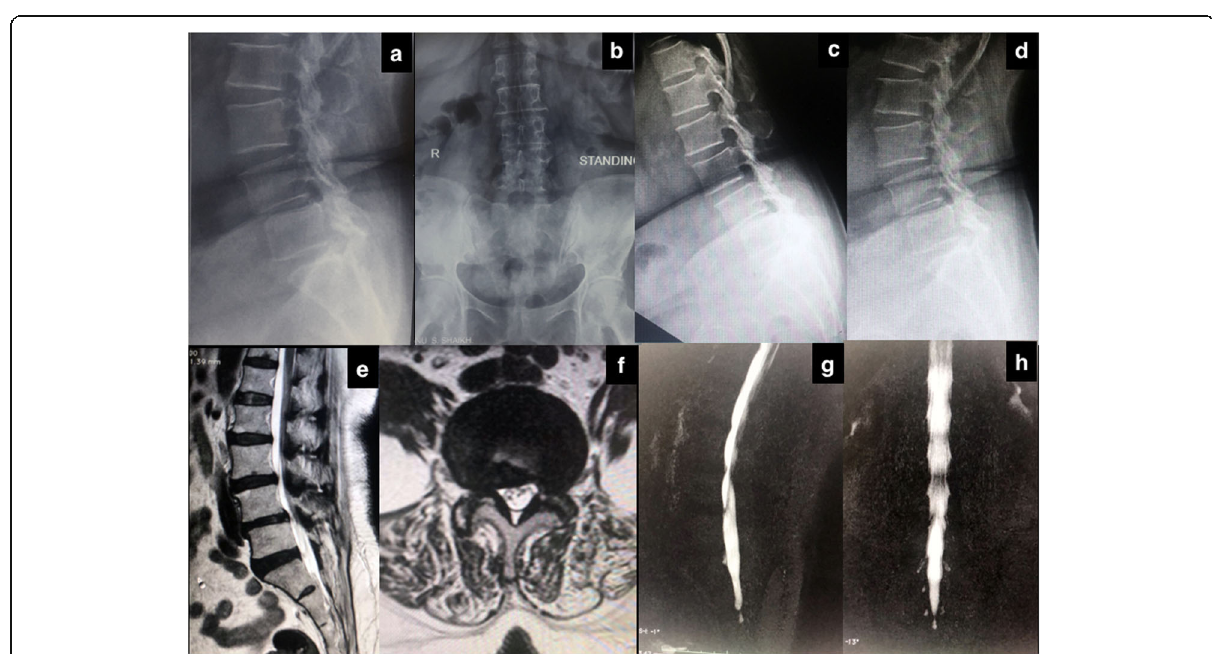
Fig. 6 a – d At follow-up standing antero-posterior, neutral standing lateral, flexion, and extension radiograph of the patients showing stable listhesis. e , f T2 axial and para-saggital MRI sections showing maintained decompression. g , h The MR myelogram showing no